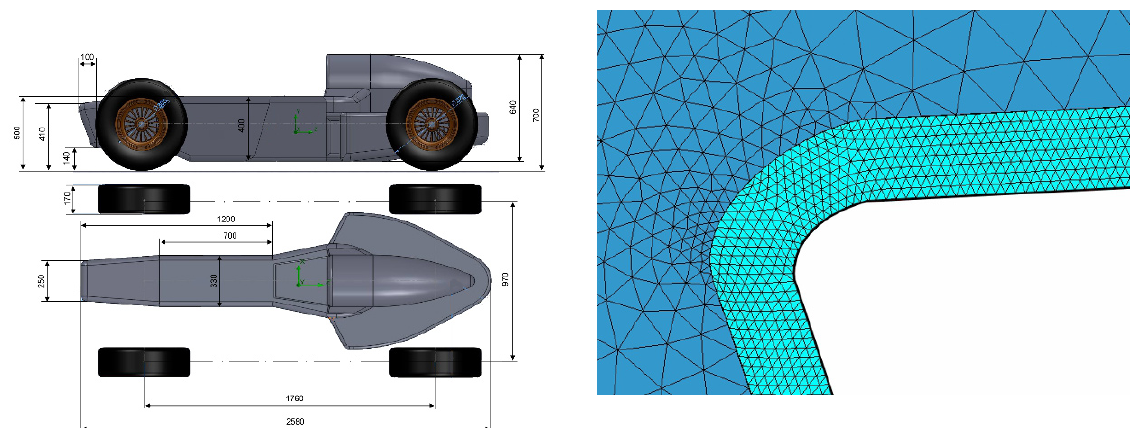
Figure 1. Formula SAE Student chassis.